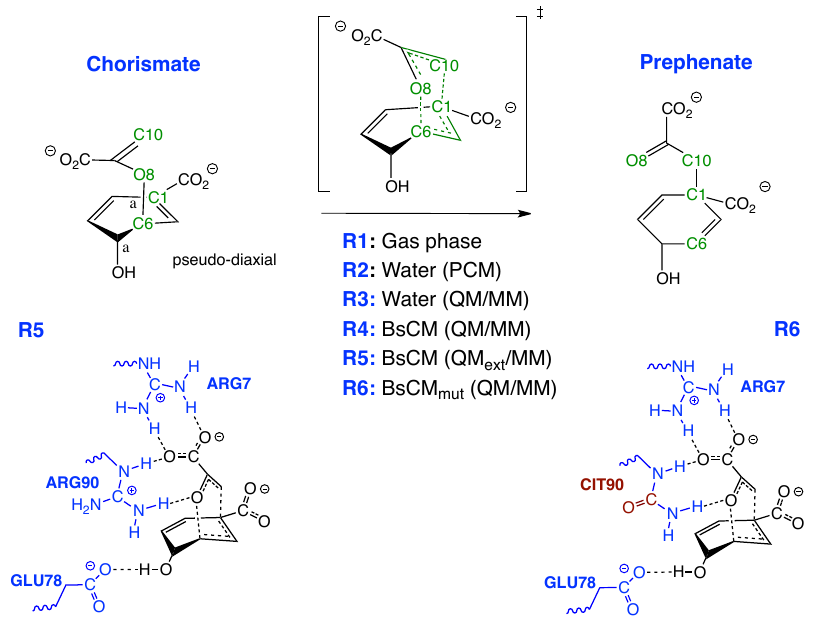
Figure 7. Claisen rearrangement of chorismate in different environments. Gas phase , R1 ; aqueous solution : R2 solvent effects described via a polarizable continuum model [133]; R3 , solvent effects described via QM/MM using the TIP3P water model [135]; reaction in BsCM described with QM/MM: R4 , QM part: chorismate only, MM part: BsCM; R5 , QM part: chorismate plus side chains of Arg90, Arg7, and Glu78 of BsCM, MM part: remaining BsCM atoms, R6 : QM part: chorismate, MM part: BsCM with Arg90 exchanged to Cit90. B3LYP/ 6-31+G(d,p) model chemistry for reactions R1 and R2 and the QM part of reactions R3 – R6 , MM part R3 – R6 being described with the AMBER force field. For further details, see Computational Methods and Supplementary